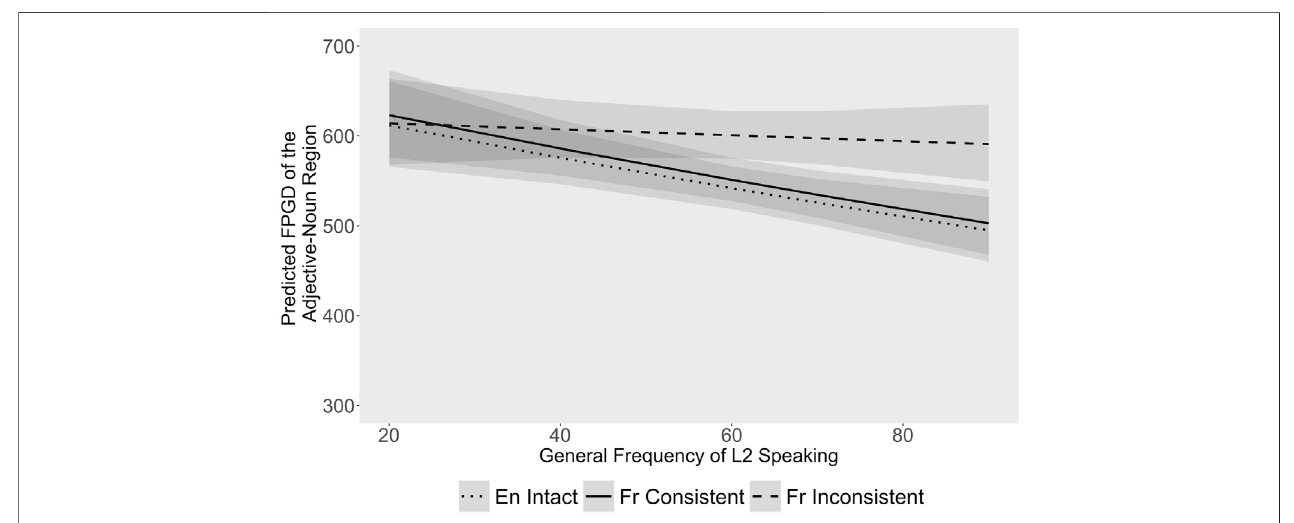
Frontiers in Communication |